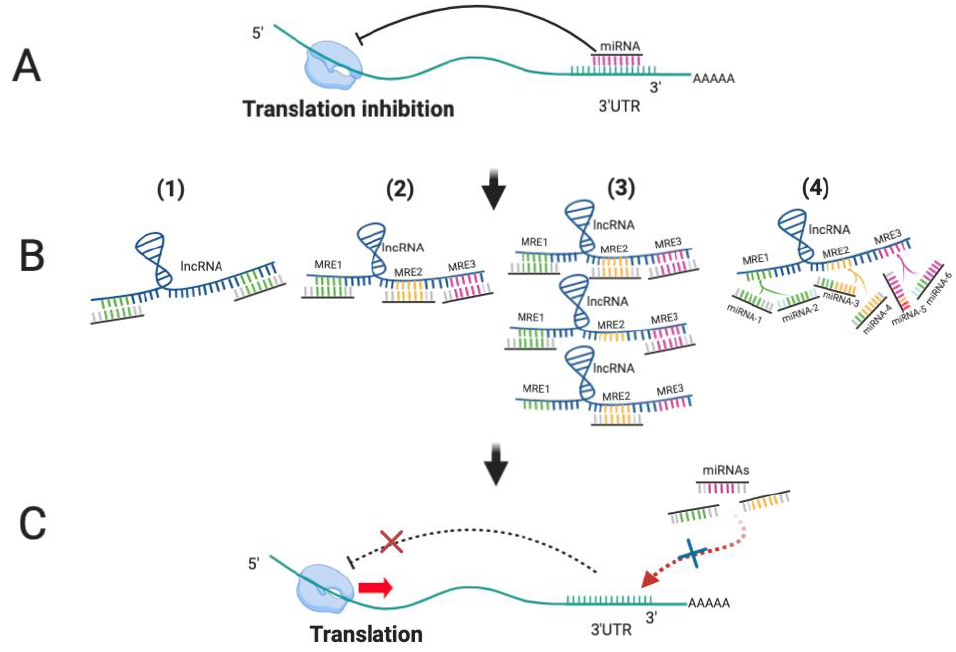
Figure 2. LncRNAs function as competing endogenous RNAs (ceRNAs) to sponge miRNAs. ( A ) miRNAs bind to the 3 (cid:48) UTR of their target mRNAs to block translation; ( B ) (1) LncRNAs